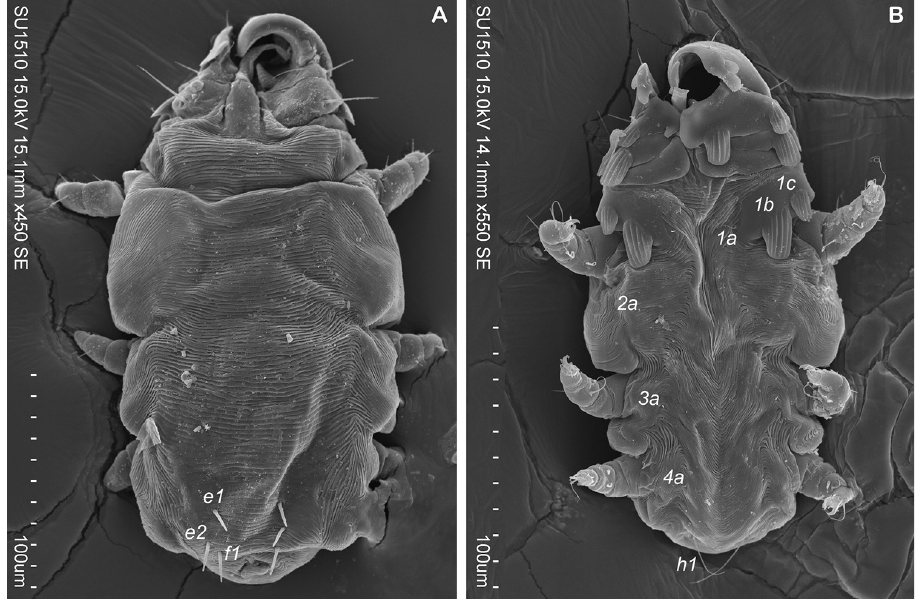
Figure 4. Ioanella mimon , tritonymph. A Dorsal view B Ventral